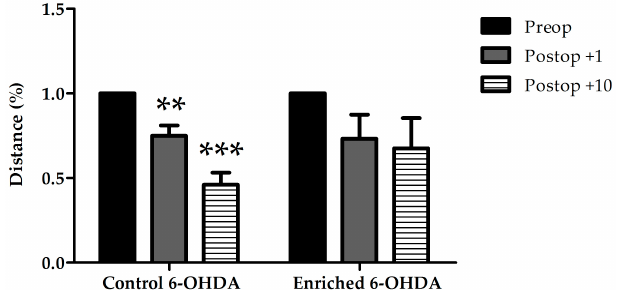
Figure 3. Distance covered in 6-OHDA-treated control and enriched animal groups before (Preop), 1 day, and 10 days after the lesion (Postop +1, +10, respectively). In the graph the percentage of distance covered is shown compared to preoperative data of the same group. Values are given as mean ± S.E.M., where 100% = 1.0. ** p < 0.01, *** p < 0.001 versus preoperative data of the same group.